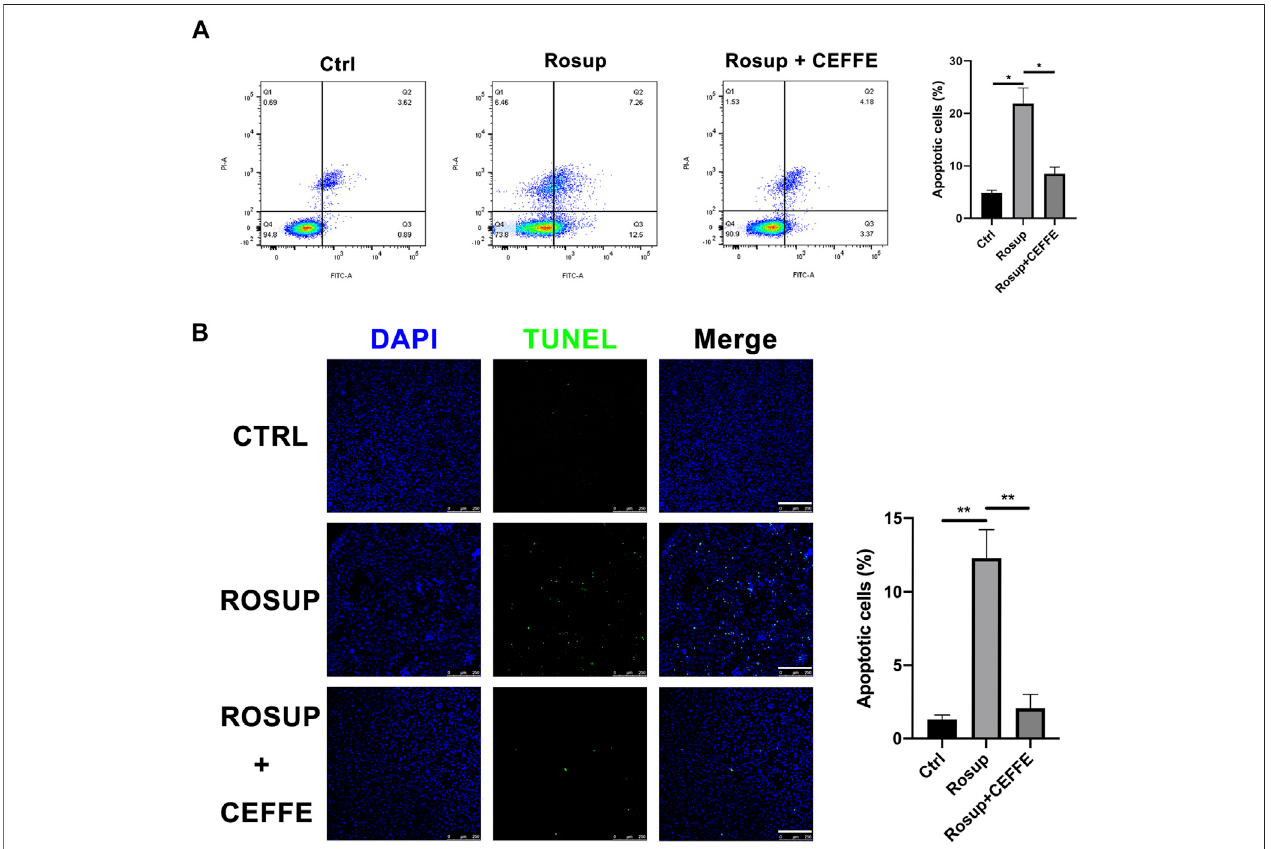
FIGURE 5 | CEFFE rescued osteocyte apoptosis induced by reactive oxygen species. Flow cytometry fi ndings show that CEFFE (250 μ g/ml) signi fi cantly decreased apoptosis ratios in MLO-Y4 cells induced by Rosup for 8 h (A) . Fluorescent green TUNEL staining (B) , corresponding blue nuclear counterstaining and merged channelsofrepresentative livesections (magni fi cation×100); ratio(%)ofTUNEL-positivecells(N=3).Scalebars,200 μ m.Dataareshown asmeans±SD,* p < 0.05, ** p < 0.01 vs control.